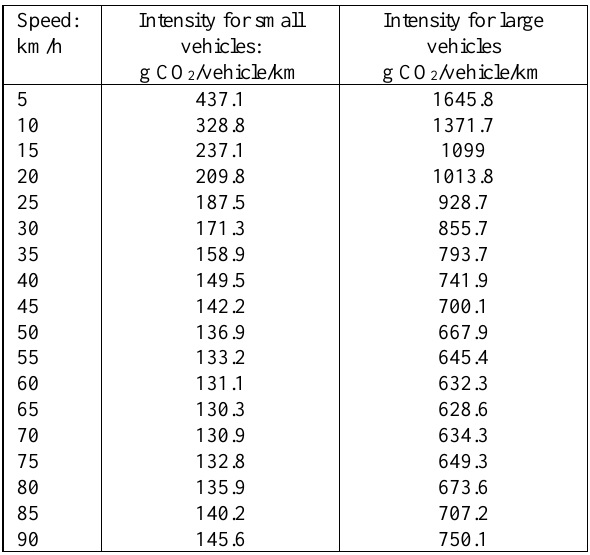
Table 1. Carbon intensity data by 2 types of vehicles used